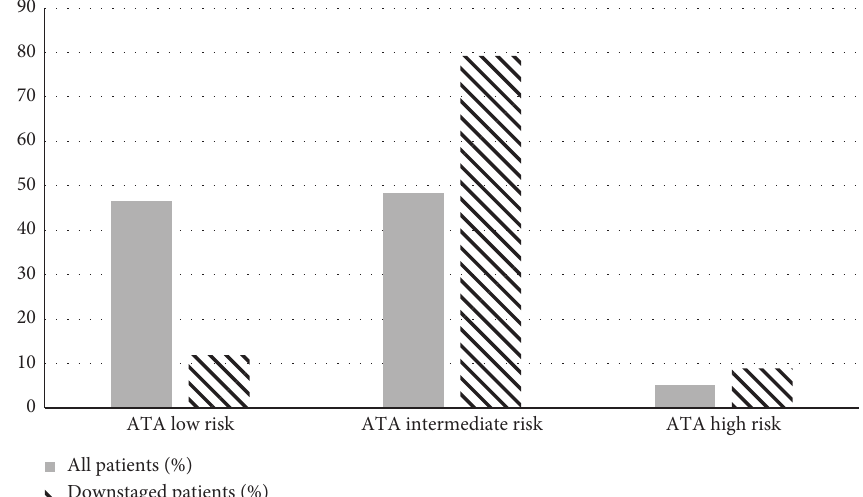
Figure 1: The American Thyroid Association (ATA) risk of recurrence (%) in all patients (columns on the left) and in downstaged patients according to the 8 th edition of AJCC-TNM staging system (columns on the